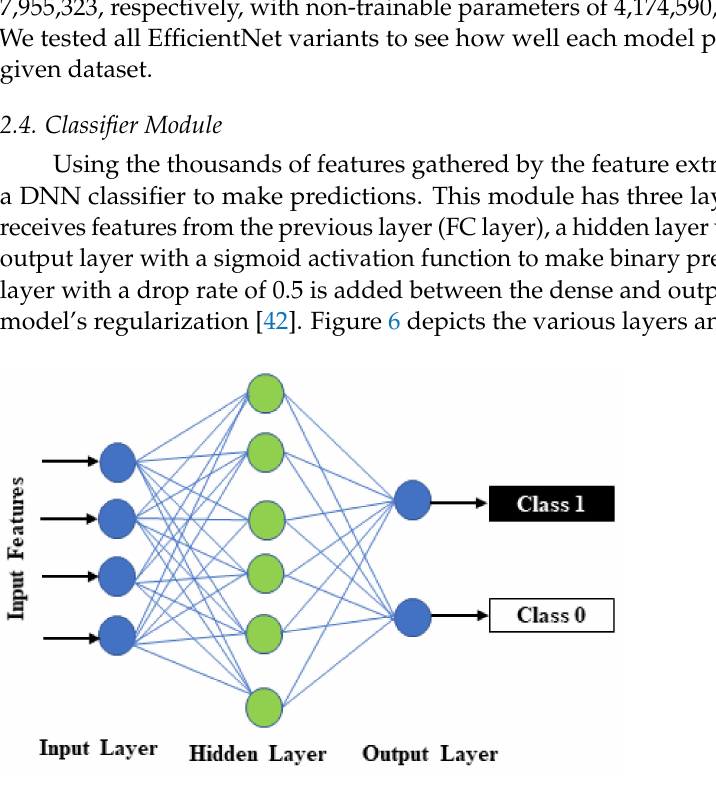
Figure 6. DNN-based binary image